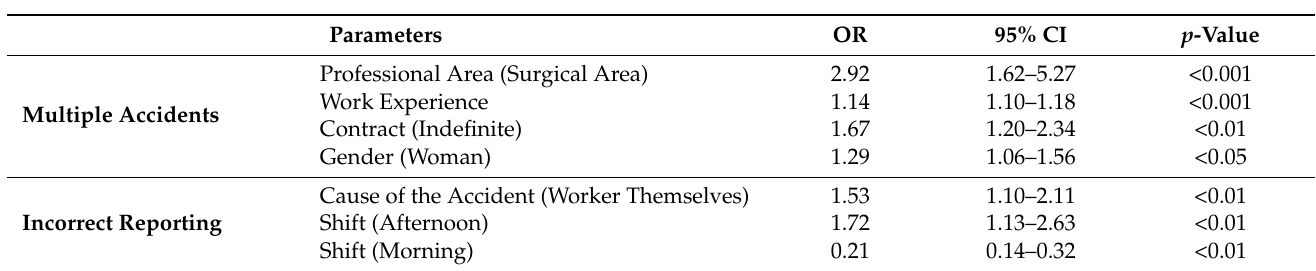
Table 3. Binary logistic regression analysis for multiple biological hazard accidents and incorrect